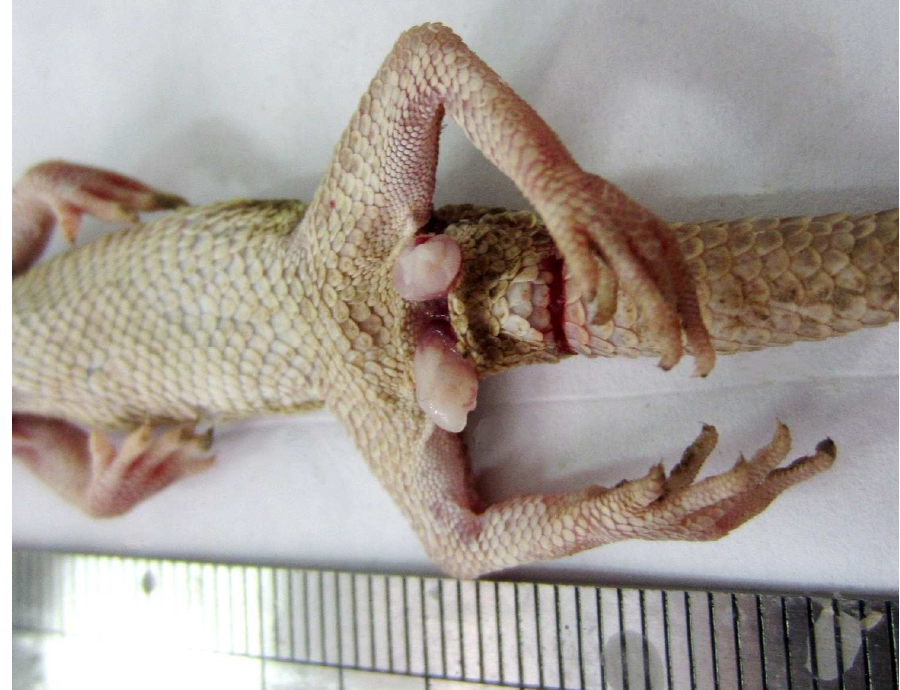
F IGURE 7. Hemipenes of Teratoscincus bedriagai